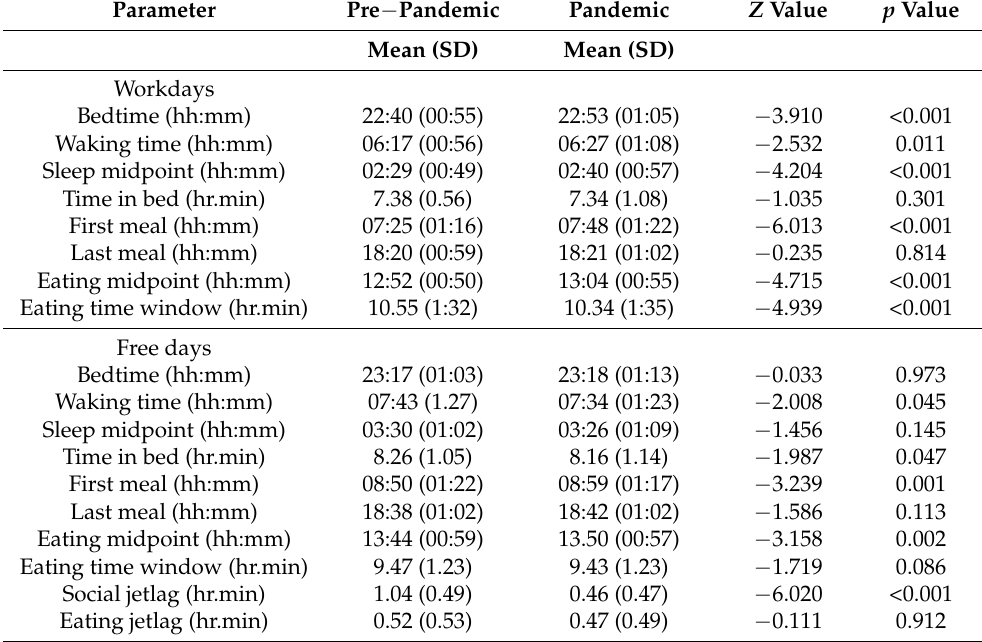
Table 1. Sleep and meal timing before and amid the COVID-19 pandemic, on work and free days. Social jetlag was calculated by subtracting the sleep midpoint of workdays from the free days’ sleep midpoint. Eating jetlag was calculated by subtracting the meal midpoint of workdays from the free days’ meal midpoint. Due to skewness of the data, comparisons between the time points were analyzed with the non-parametric Wilcoxon signed-rank test. A p -value smaller than 0.0028 was considered significant (shown in bold; p = 0.05 divided by 18 comparisons). Data are shown as mean ± standard deviation (SD). Abbreviations: hh:mm, military time; hr.min, hours +